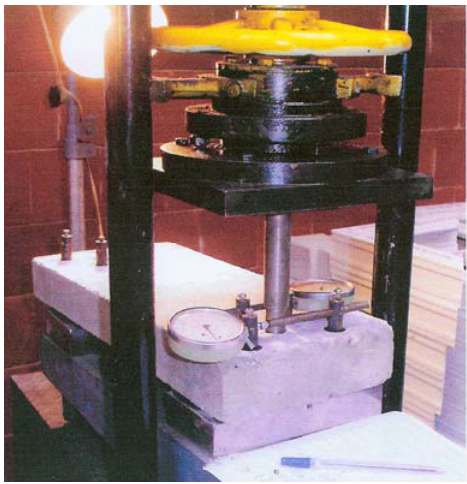
Fig 5. General view of the test set up